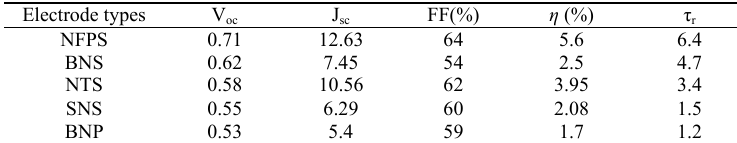
Table 1. Photovoltaic parameters for different photoanode electrodes